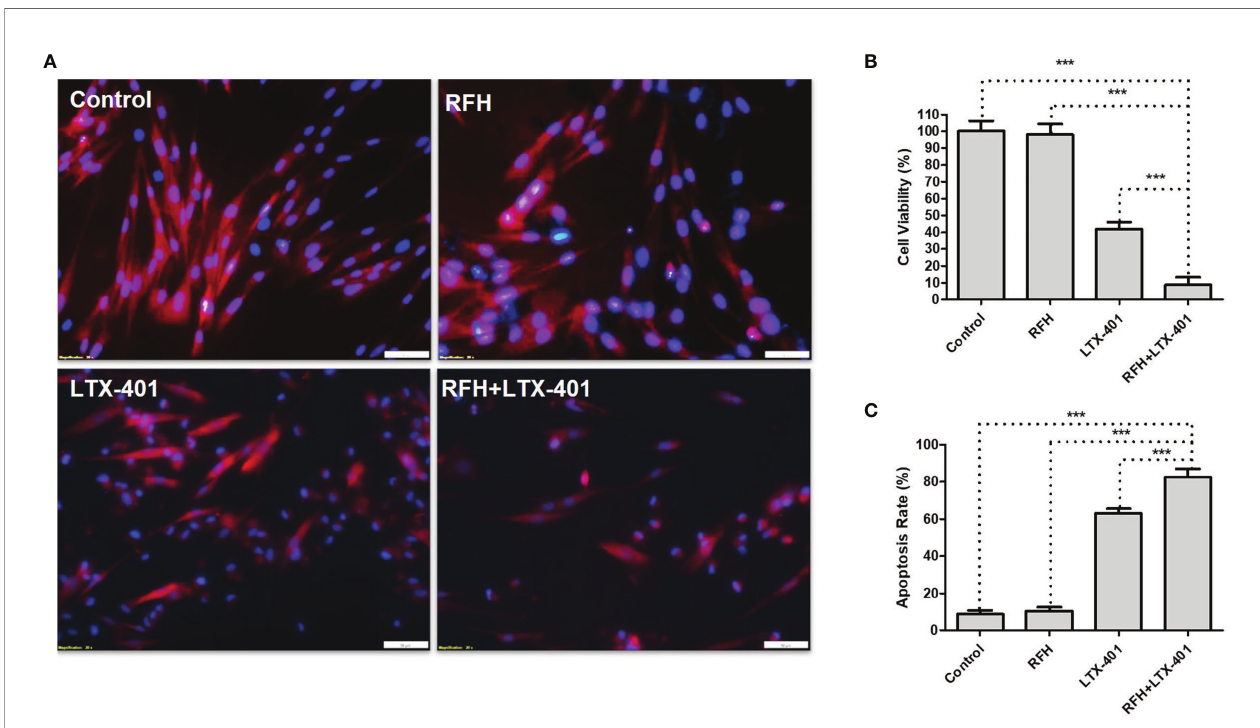
FIGURE 5 | Fluorescence microscopic images, cell viability and apoptosis analysis. (A) Fluorescence microscopic images of different cell groups with various treatments, demonstrating a decrease of ICG signal (pink) and nuclear atrophy (blue), as well as the reduction in cell size with the combination therapy of RFH + LTX- 401 (Scale bars, 50 m m). (B) MTS assay for evaluation of cell viability after different treatments, showing a signi fi cant decrease of cell viability with the combination therapy of RFH + LTX-401, compared to other treatments (***= P <0.005). (C) Annexin V-FITC/7-AAD fl ow cytometry for evaluation of cell apoptosis further demonstrates a signi fi cant highest apoptosis with the combination therapy of RFH + LTX-401, compared to other monotherapies (***= P